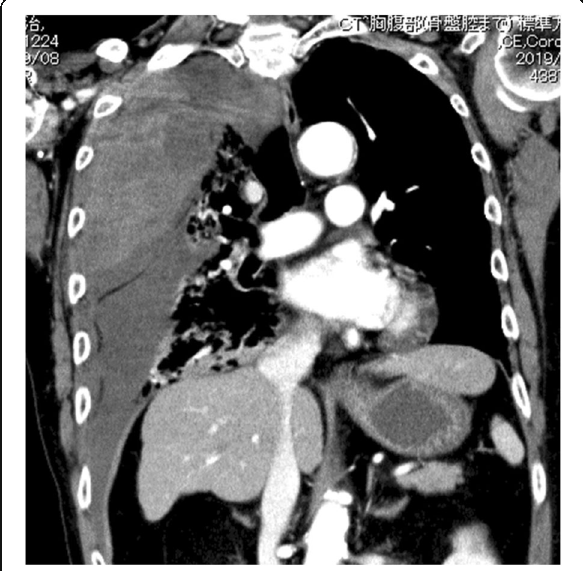
Fig. 2 Chest computed tomography (CT) scan showing a hematoma in the extrapleural